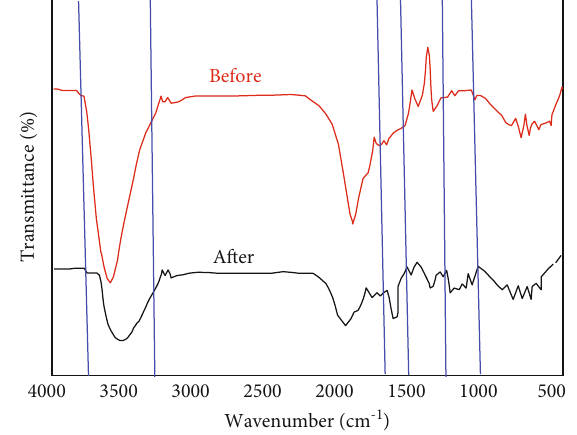
Figure 9: FT-IR spectra of CaFe and after the adsorption of RO12